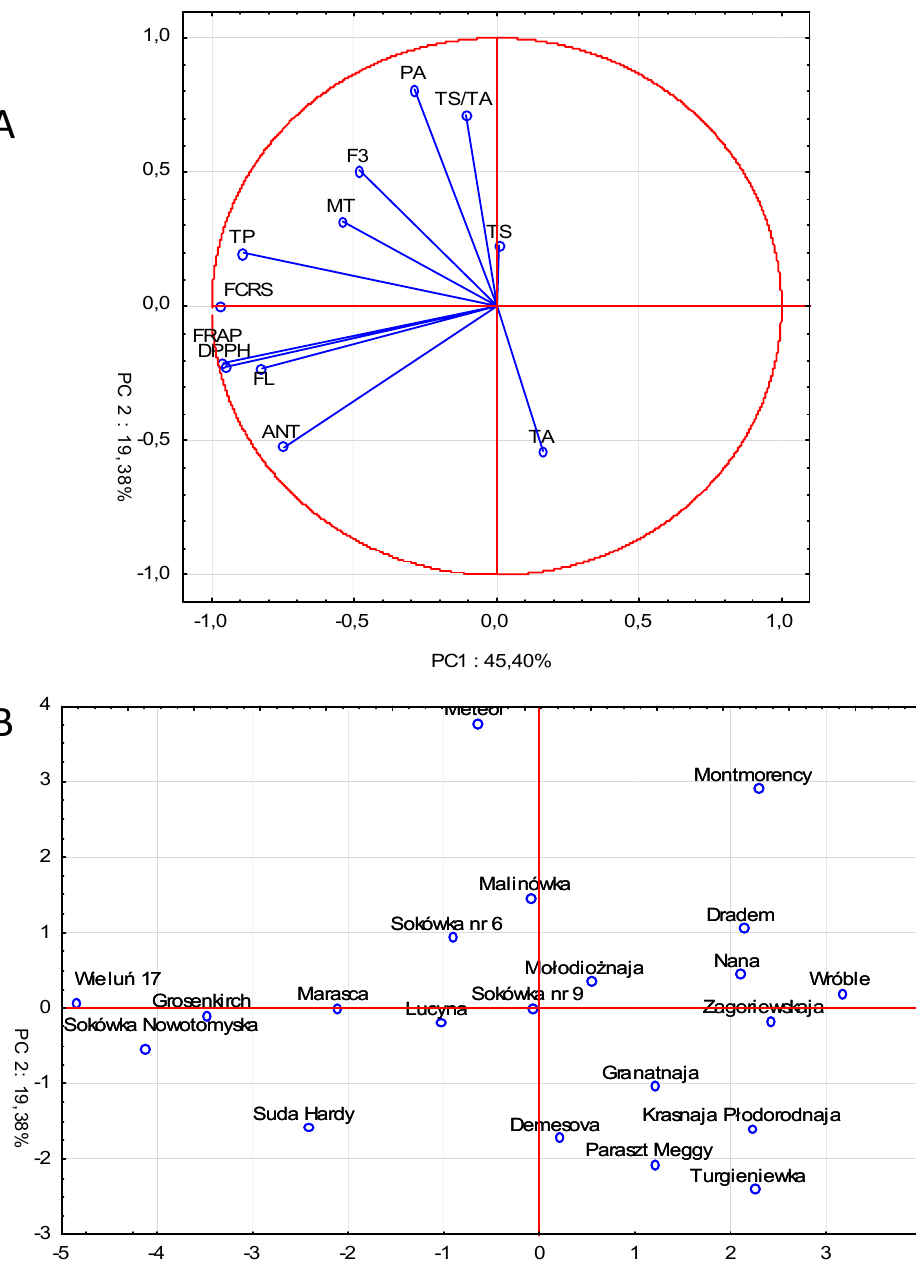
Figure 5. Principal component analysis (PCA) ( A ) score and loading plots ( B ) for sour cherry cultivars (ANT—anthocyanins, FL—flavonols, PA—phenolicacids, F3—flavan3-ols,